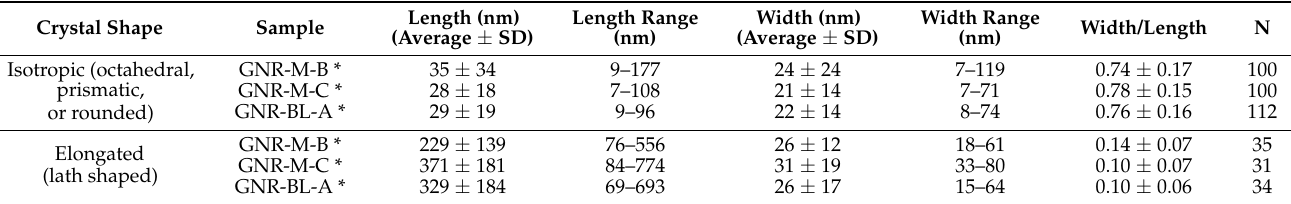
Figure 7. Length/width plots of minerals from the black magnetic solids produced in long-term enrichment cultures retrieved after 170 days. Open circles, isotropic crystals; closed circles, lath-shaped, anisotropic crystals. Note a clear shape distinction between these two minerals, as indicated by the linear fits. ( a ) GNR-M-B, ( b ) GNR-M-C, and ( c ) GNR-BL-A. See Table 1 for more information on the samples. Table 3. Size and shape factor of crystalline particles observed by transmission electron